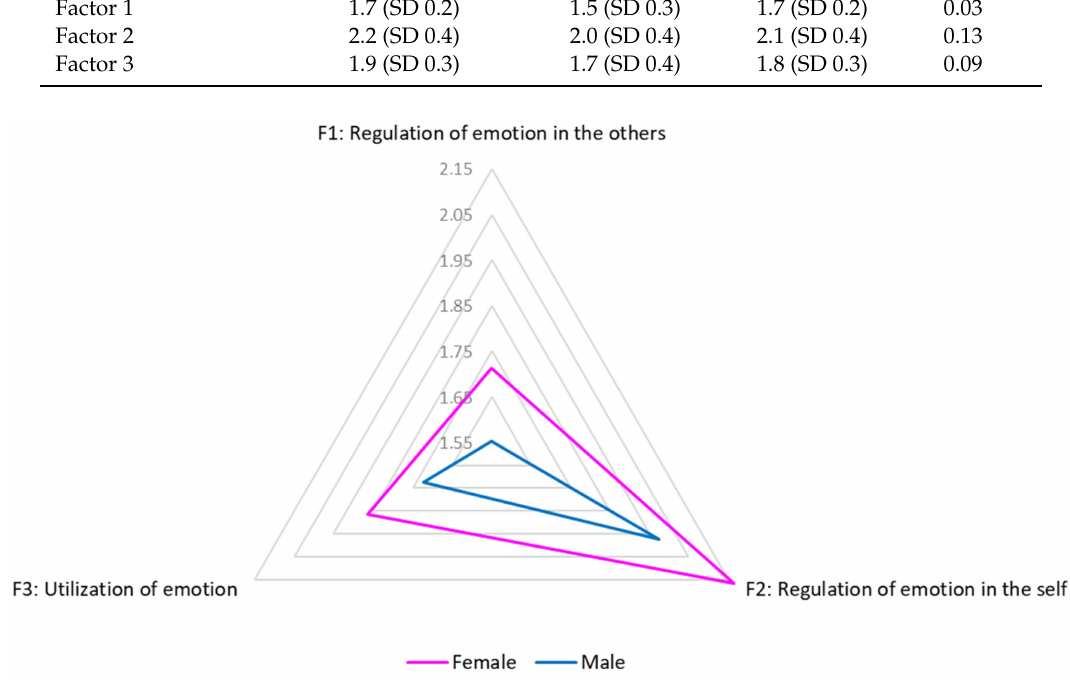
Figure 1. Graphical representation of emotional intelligence factors by gender. Considering age, no significative correlations were found with emotional intelligence (EI) factors (Pearson’s r ; p >